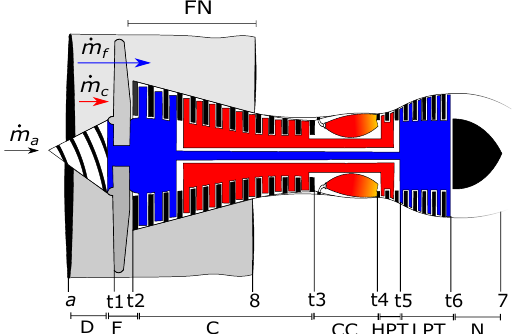
Figure 1. Schematic diagram of a turbofan